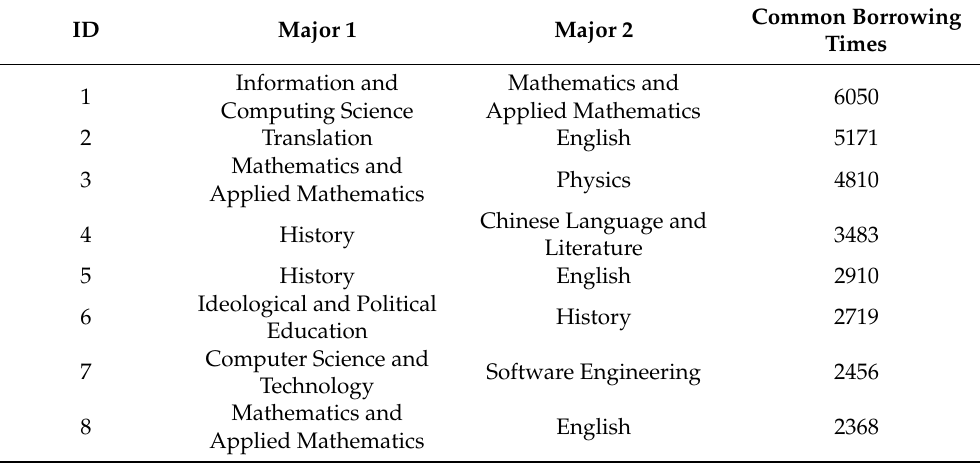
Table 4. Major and corresponding major data sheet.